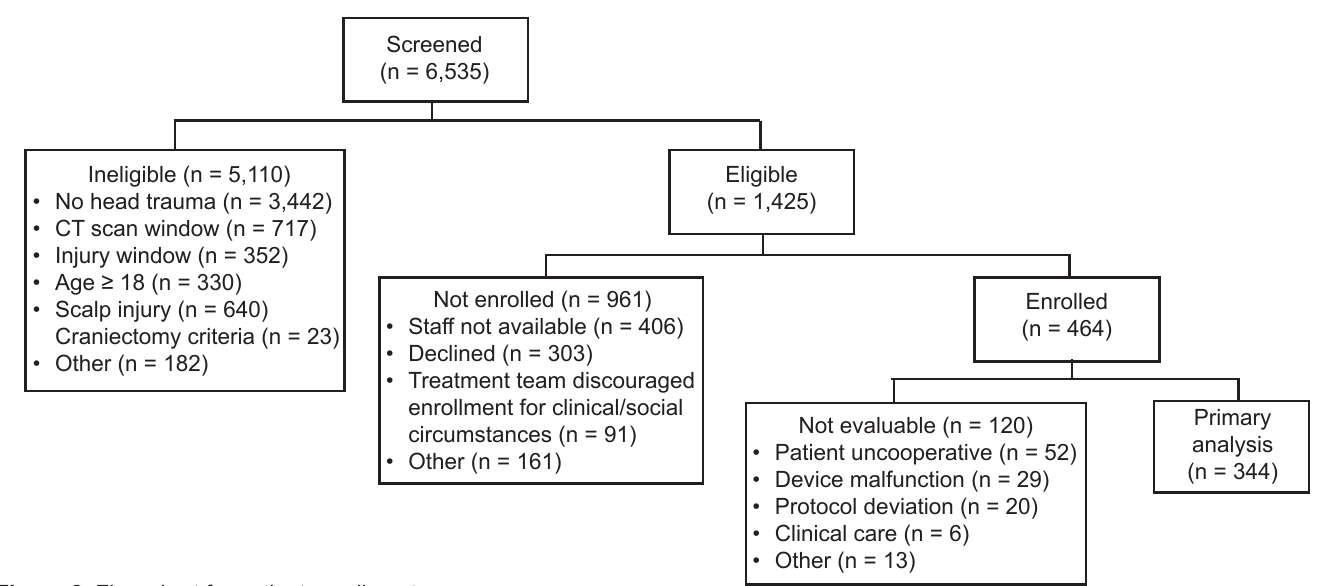
Figure 2. Flow chart for patient enrollment. CT , computed